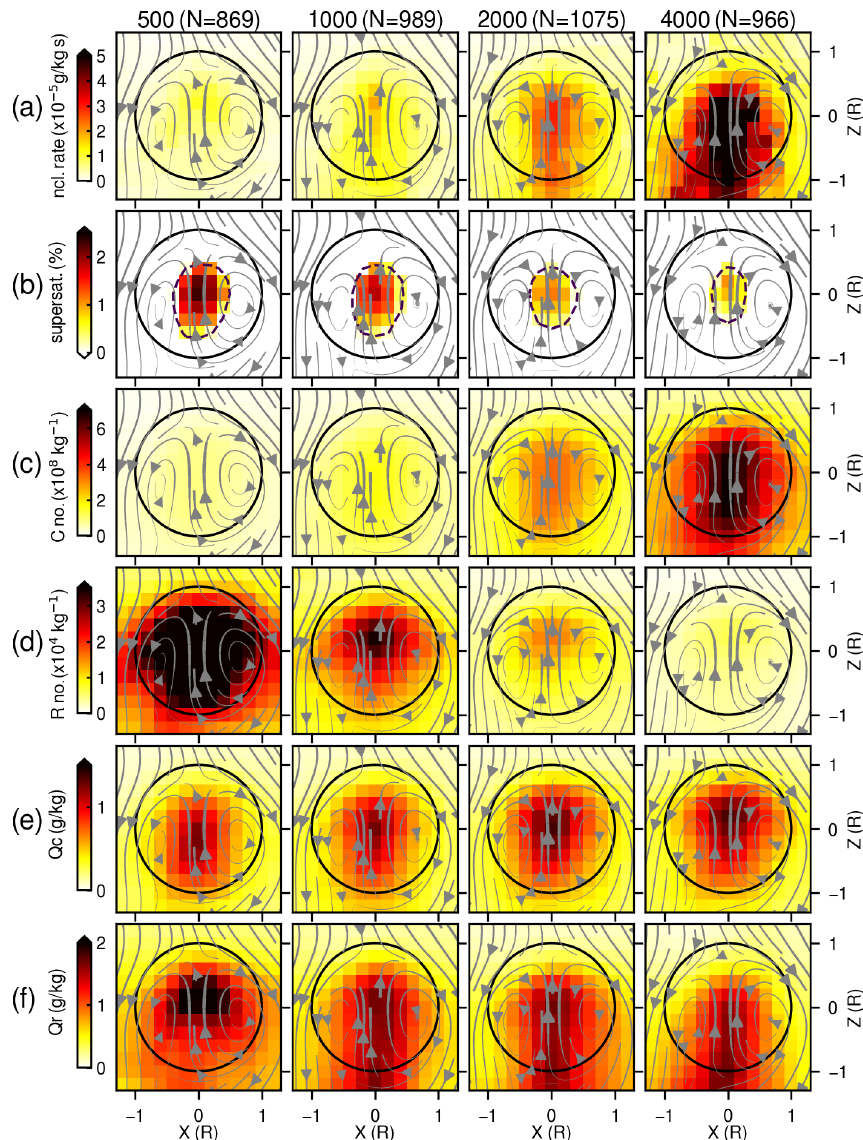
Figure 2. Cross sections along the xz plane of mean values of (a) cloud nucleation rate, (b) supersaturation values, (c) cloud drop number concentration (C no.), (d) rain number concentration (R no.), (e) cloud liquid water mixing ratio (Qc), and (f) rain mixing ratio (Qr), for composites of all tracked thermals scaled by their radius (horizontal and vertical coordinates are in units of mean thermal radii). Each column corresponds to a simulation with initial aerosol number concentration (indicated above in counts per cubic centimeter; hereafter cm − 3 ). N corresponds to the number of tracked thermals used for the composites. Arrows indicate the streamlines of the average flow in the reference frame of the rising thermal. The dashed contour in supersaturation values corresponds to 100% relative